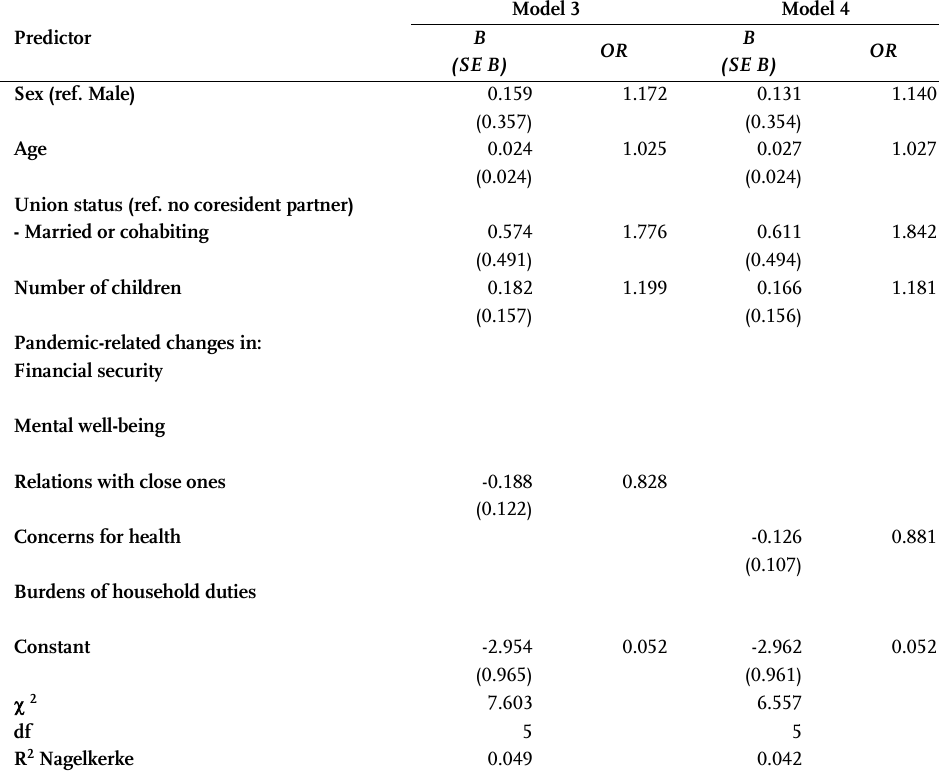
Model 3 Model 4